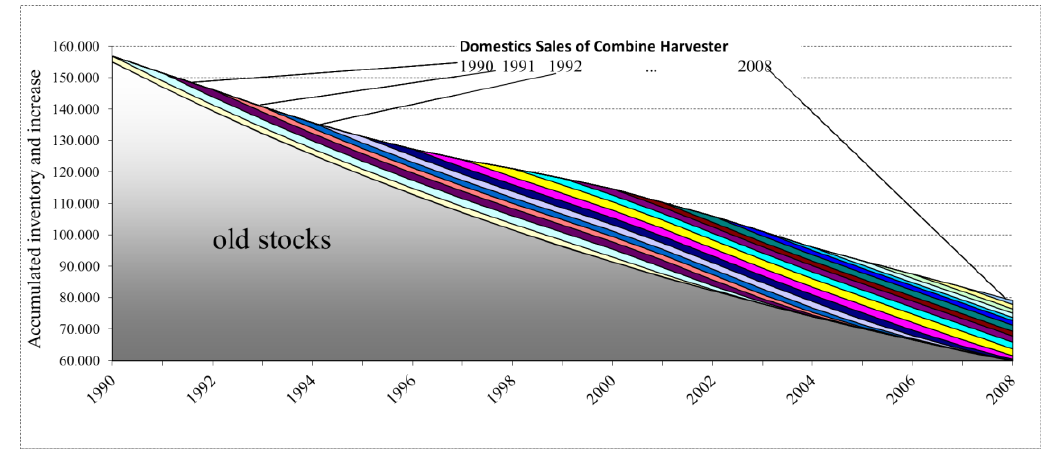
Figure 3. Inventory of combine harvesters (old stocks; domestic sales 1990 to 2008—colored lines; all area together = accumulated inventory) 1990–2008. Source: Own calculations based on